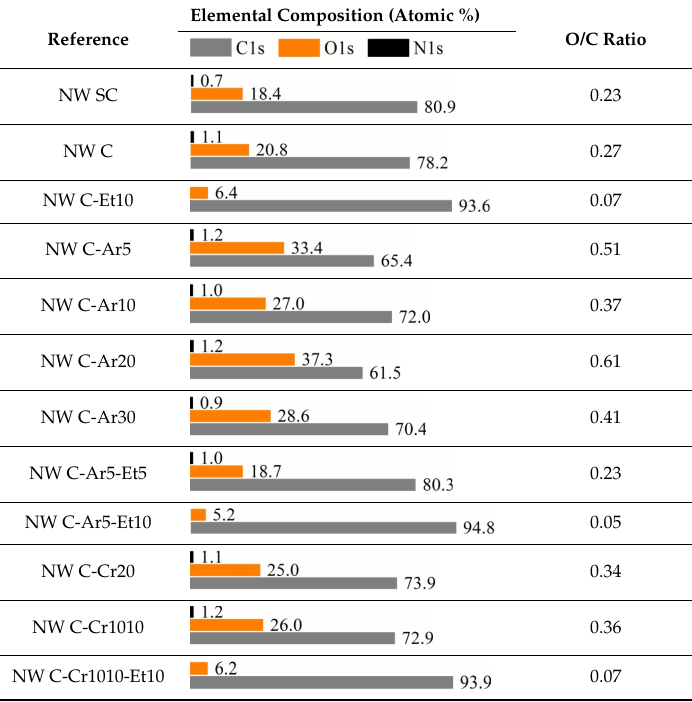
Table 2. Elemental composition percentage and oxygen to carbon (O/C) ratios for all the nonwoven (NW) samples obtained by X-ray photoelectron spectroscopy